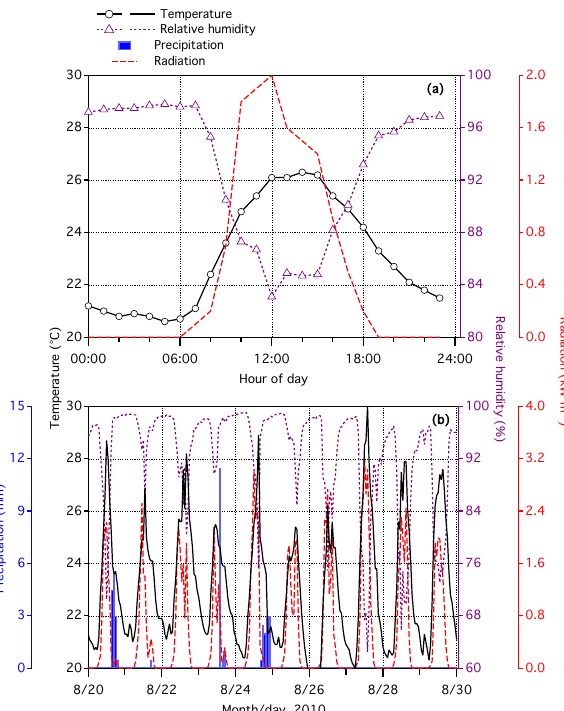
Figure 2. Meteorological parameters during 20–30 August 2010 in the Wakayama forest for (a) averaged diurnal variations of temper- ature, relative humidity and solar radiation and (b) hourly means over the periods. Hourly precipitation was also shown in (b)